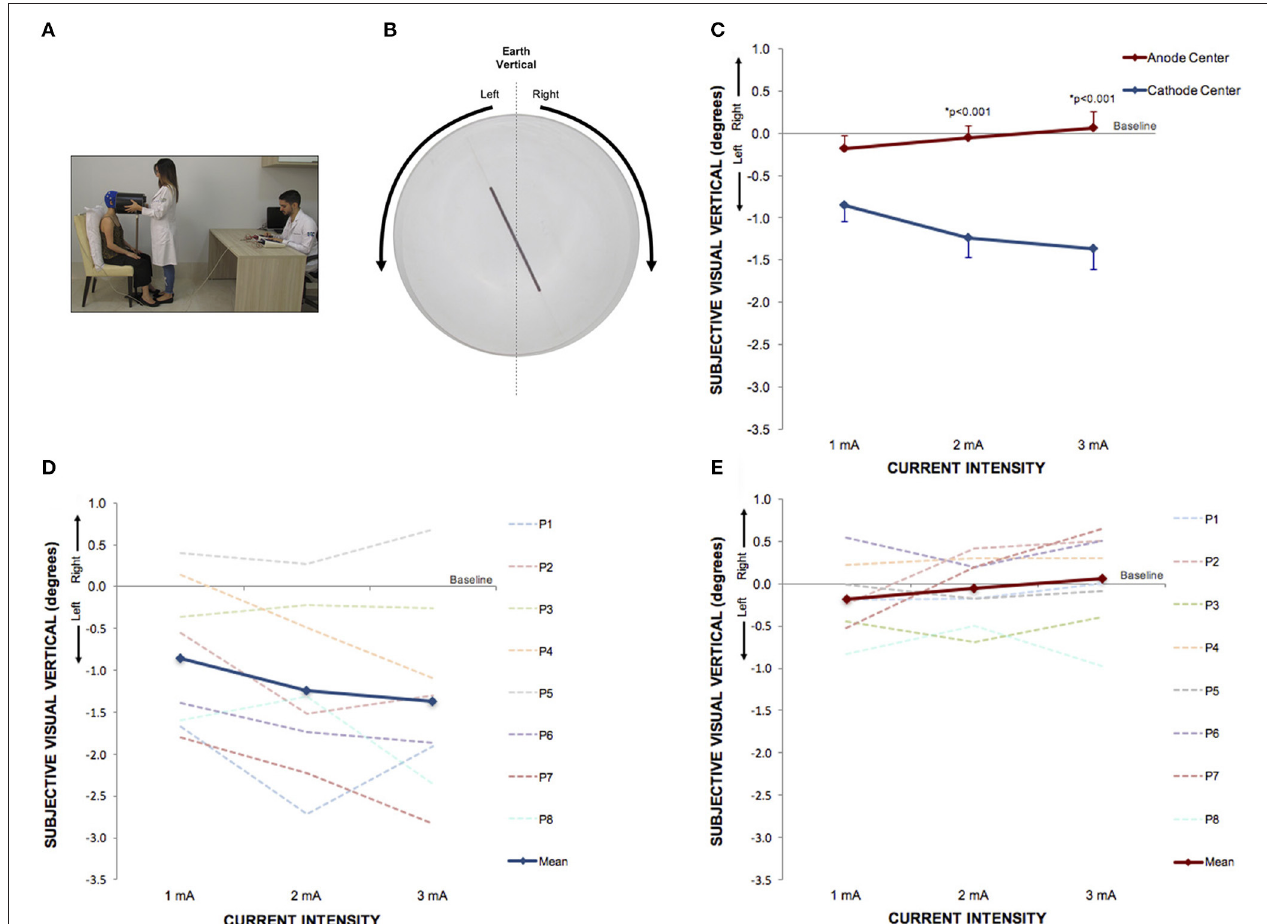
FIGURE 4 | Perception of visual vertical can be manipulated by cathode center condition of HD-tDCS 3 × 1 over the right temporo-parietal junction. (A) Experimental set up of the visual vertical trial. (B) The line inside the bucket used to assess visual vertical perception from the participant’s perspective. The arrows illustrate the side of the bucket’s rotation. (C) Difference between the SVV assessed at baseline and at current intensities of 1, 2, and 3mA (mean; s.e.m.). There were intensity and polarity-dependent effects only after cathode center HD-tDCS 3 × 1 condition. (D) Difference between the SVV assessed at baseline and at current intensities of 1, 2, and 3mA after cathode center HD-tDCS 3 × 1 condition of each participant showing the variability of the data and overall leftward tilt with progressively increase of SVV tilt with increasing stimulus intensity (mean; s.e.m.). (E) Difference between the SVV assessed at baseline and at current intensities of 1, 2, and 3mA after anode center HD-tDCS 3 × 1 condition of each participant showing the variability of the data and overall absence of effects. Written informed consent was obtained from the participants for the publication of this